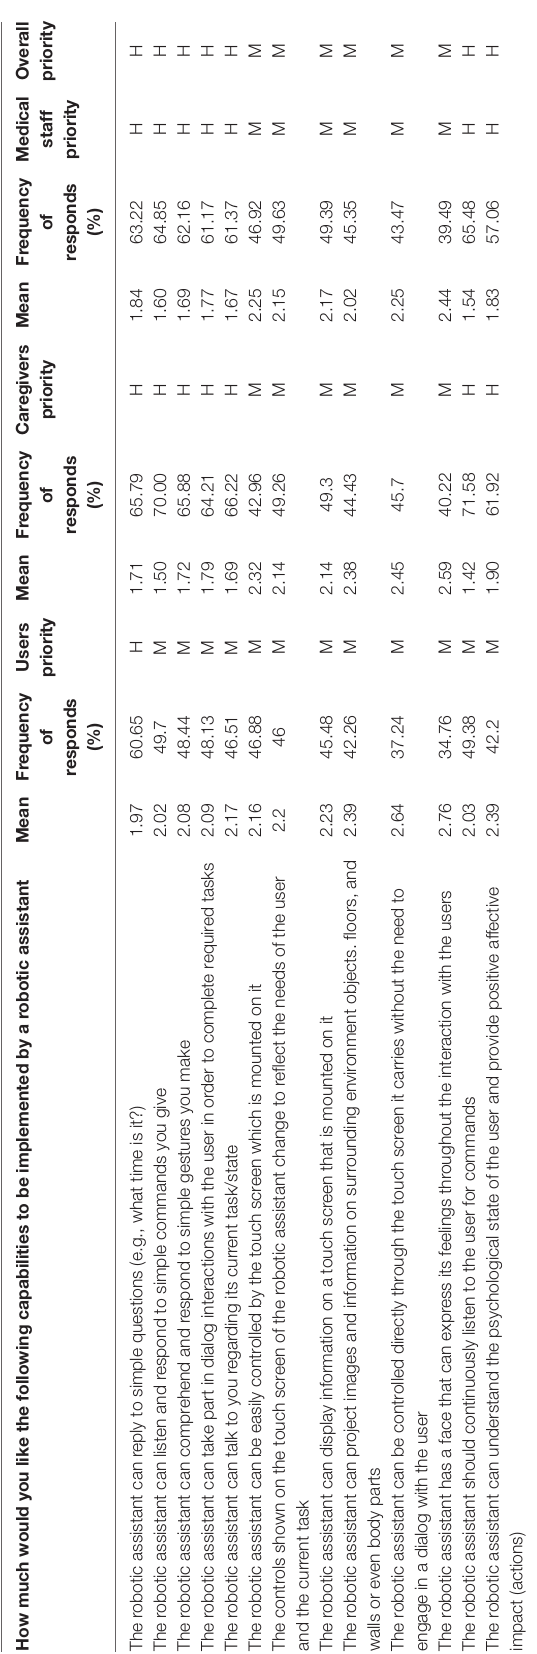
Potential caregivers both users (%) (%) groups (%)